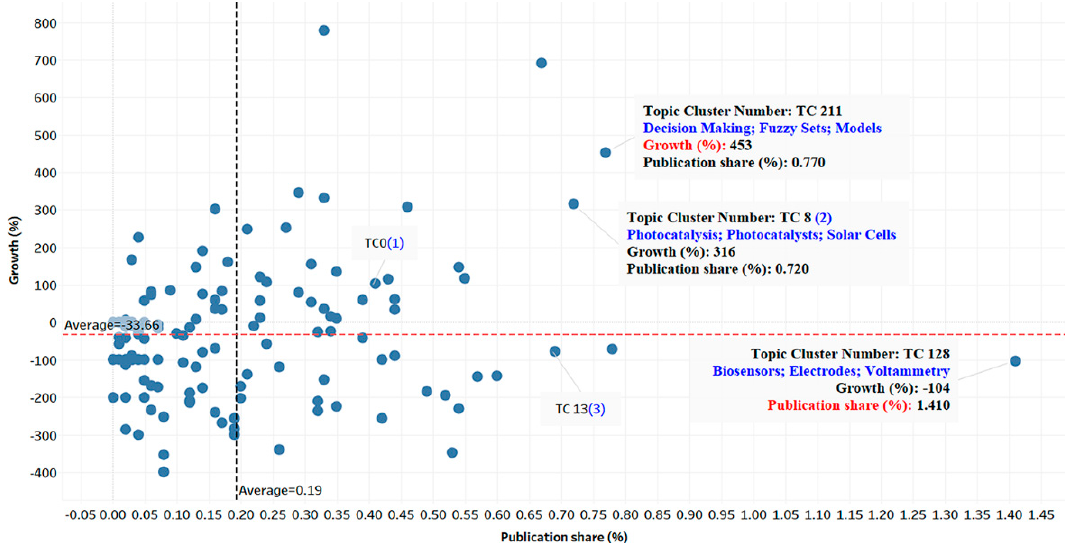
Figure 1. BCG matrix analysis of topic clusters in the top 10% of journals.